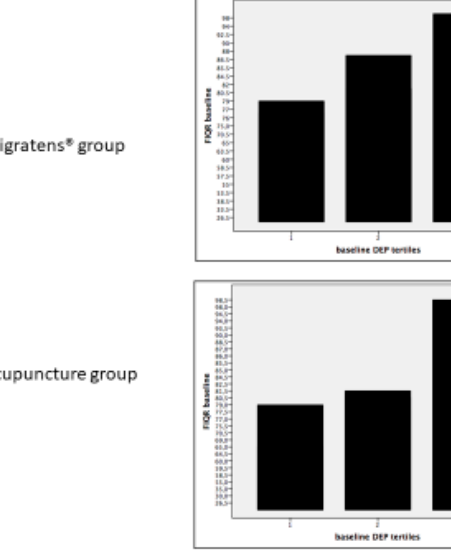
Figure 9. Linear correlation between FIQ-R and depression score expressed as tertiles in the two groups of treatment. Note that in Migratens ® Group, the positive correlation observed at baseline ( p < 0.05) was lost at the end of follow-up, while it was maintained in the Acupuncture Group ( p < 0.05).